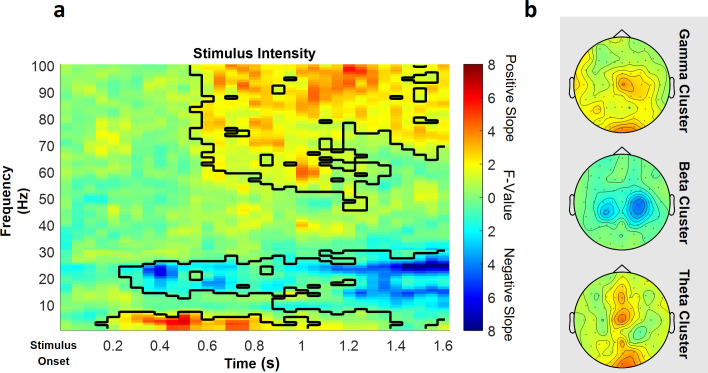
Parametric effects of stimulus intensity.Time–frequency representation averaged over all channels including a significant time–frequency sample of any cluster (a) and topographies over the whole cluster extents (i.e. full time and frequency range), respectively (b), of the stimulus intensity main effect of the repeated-measures ANOVA depicting increases (warm) and decreases (cold) in power in relation to heat stimulus intensity. Significant clusters are highlighted. Colors represent F-values from the repeated-measures ANOVA statistics for the main effect of stimulus intensity.